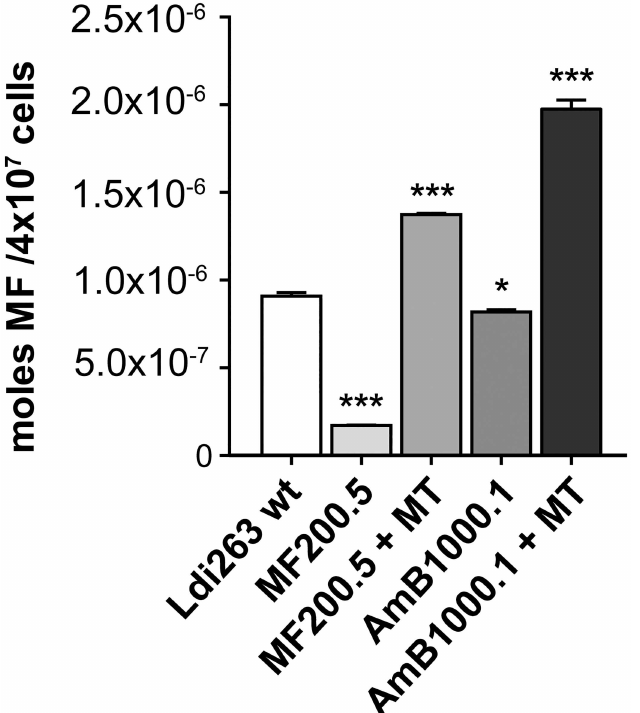
Fig 3. Miltefosine transport of drug resistant Leishmania. HistogramshowingMF accumulation for the different strains generatedand the wild-typemock-transfected line measuredby fluorescence intensity of parasites treated with 5 μ M MT-11C-BODIPY for 1 h. Untreatedparasiteswere used to subtract the background noise. Data are the mean ± S.D. of three independent experiments run in triplicate. Statistical significancebetweenthe mock-transfected wild-typeand the rest of the strains was evaluatedby unpaired two-tailedt test ( * p (cid:20) 0 . 05 , *** p (cid:20) 0 . 001 ).